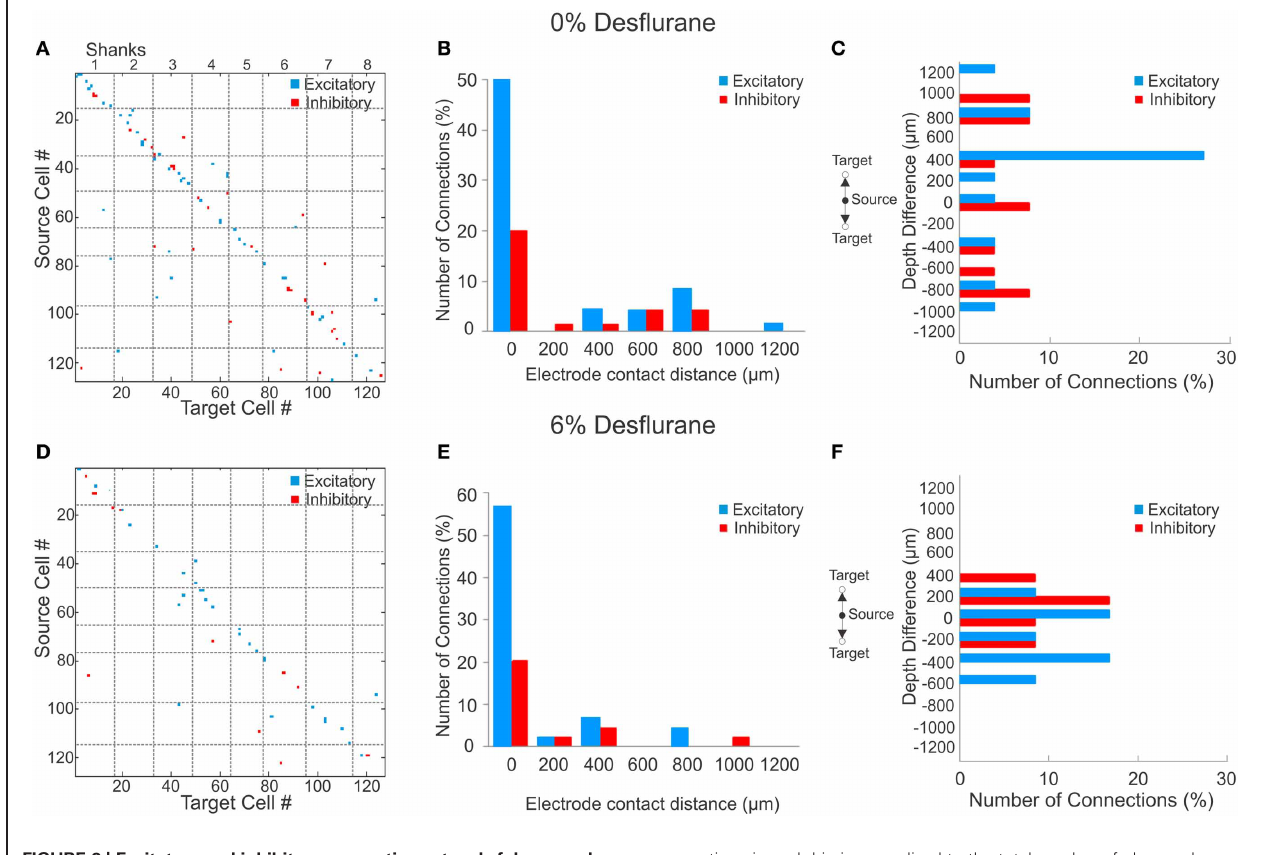
connections in each bin is normalized to the total number of observed connections (excitatory + inhibitory). Most excitatory and inhibitory connections are found within the same electrode contact (73 and 64%, respectively). (C) Distribution of depth (source depth—target depth) of excitatory and inhibitory connections from different electrode contacts at wakefulness, corrected for angle of insertion. Excitatory connections project to superficial layers. (D) Connection matrix during unconsciousness. (E) Distance distribution of functionally connected neuron pairs at unconsciousness normalized to total number of connections. Similar to the wakeful condition, both excitatory and inhibitory connections are mainly found within the same electrode contact (81 and 69%, respectively). (F) During unconsciousness the connection depth was limited to shorter